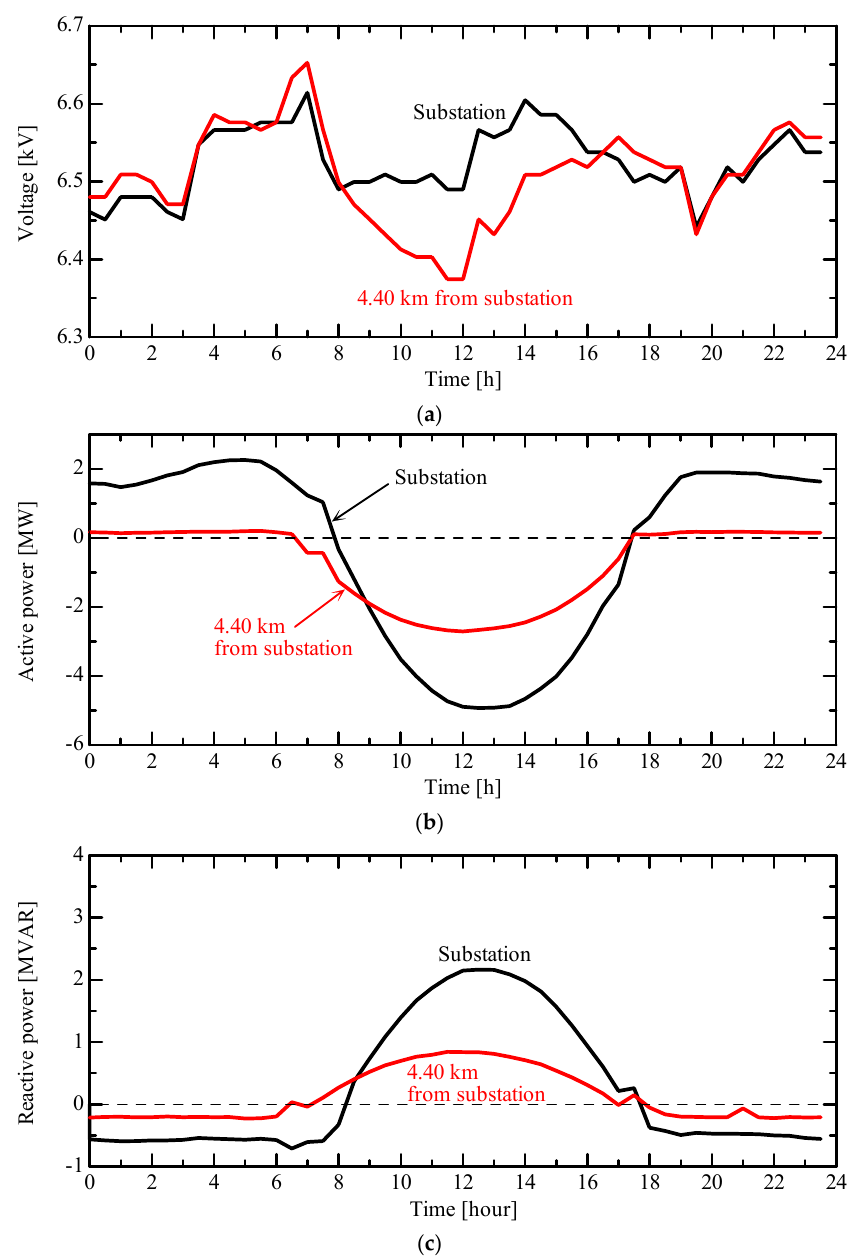
Figure 2. Measured voltage, active power, and reactive power in MV feeder A: ( a ) Voltage; ( b ) Active power; ( c ) Reactive power.